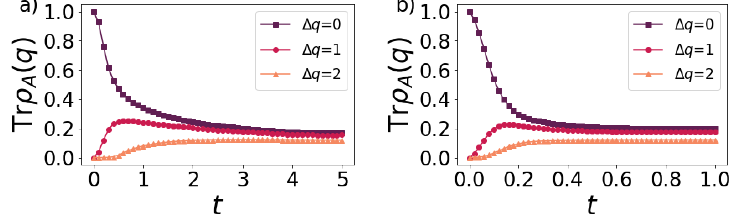
Figure 11: Population of the symmetry sectors during the evolution of the systems described in Fig.s 7a)-c). We use ∆ q = q − (cid:96)/ 2 to label the symmetry sectors. We fix J = 1, µ = 0. In panel a) 1 D chain with L = 64, (cid:96) = 32, γ = 0.05; b) 2 D square lattice, L = 16, (cid:96) = 4, γ =